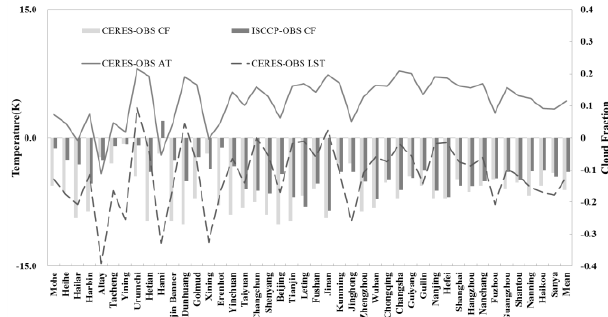
Figure 6. Multi-year average difference in the LST, AT and CF between the satellite and site measurements (OBS) at 43 sites CERES cloud data were obtained from GEOS-4 (Bloom,2005).